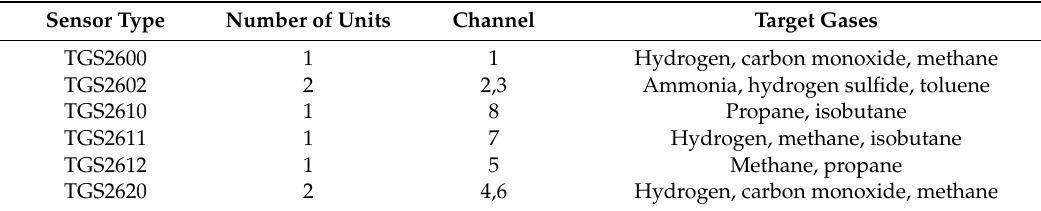
Table 2. MOX sensors information in the sensor array.